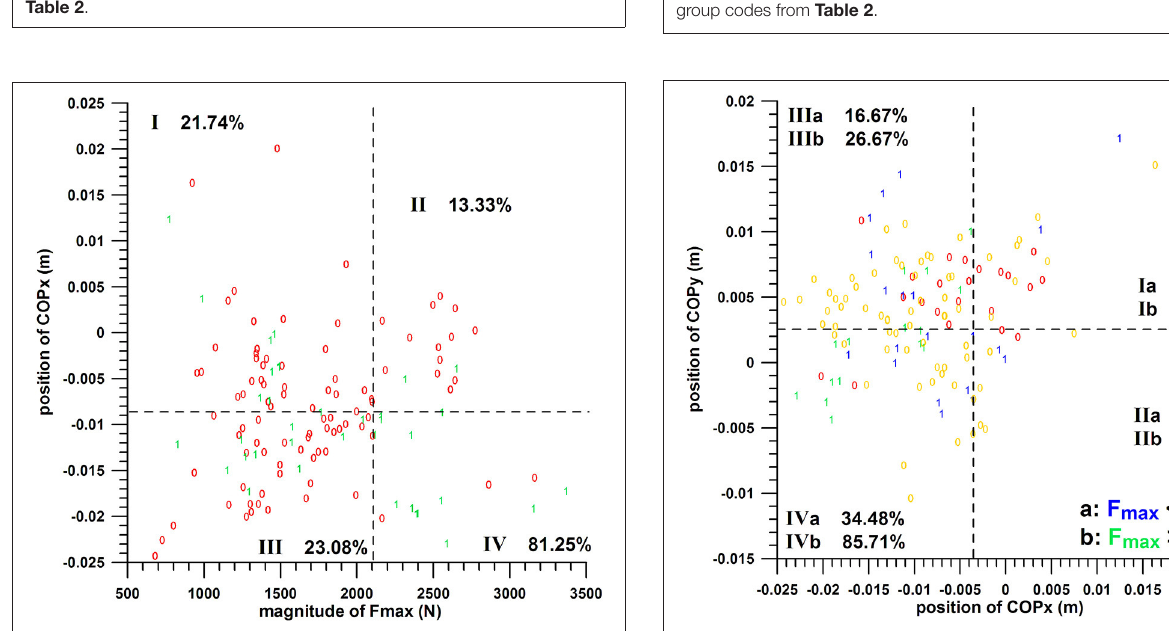
FIGURE 7 | Two-parameter analysis: COPx vs. COPy; 0 = miss, 1 = hit; dashed lines = threshold values (cf. Table 1 ); I, II, III, IV = group codes from